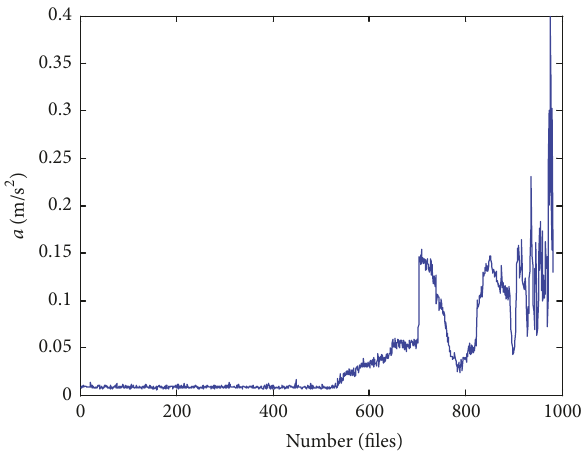
Figure 8: The ADF of the